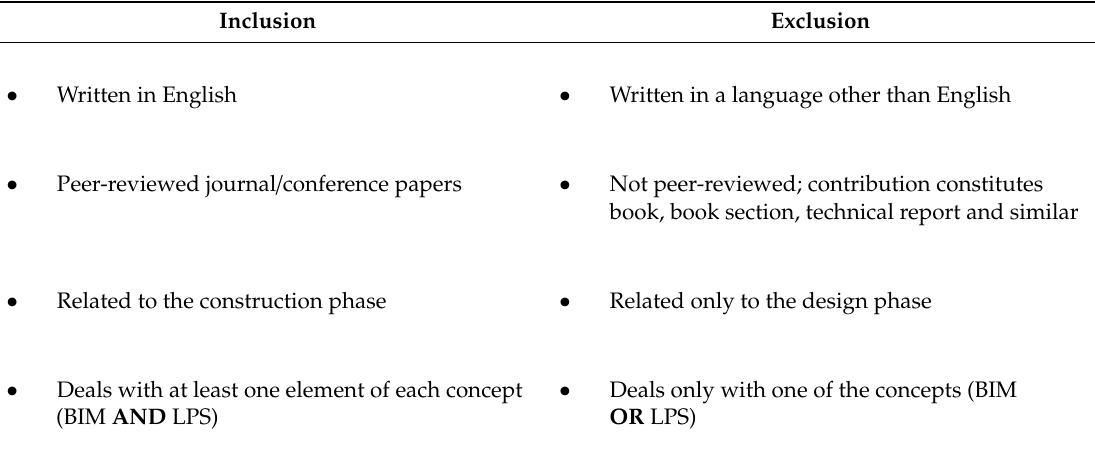
Table 3. Inclusion and exclusion criteria.